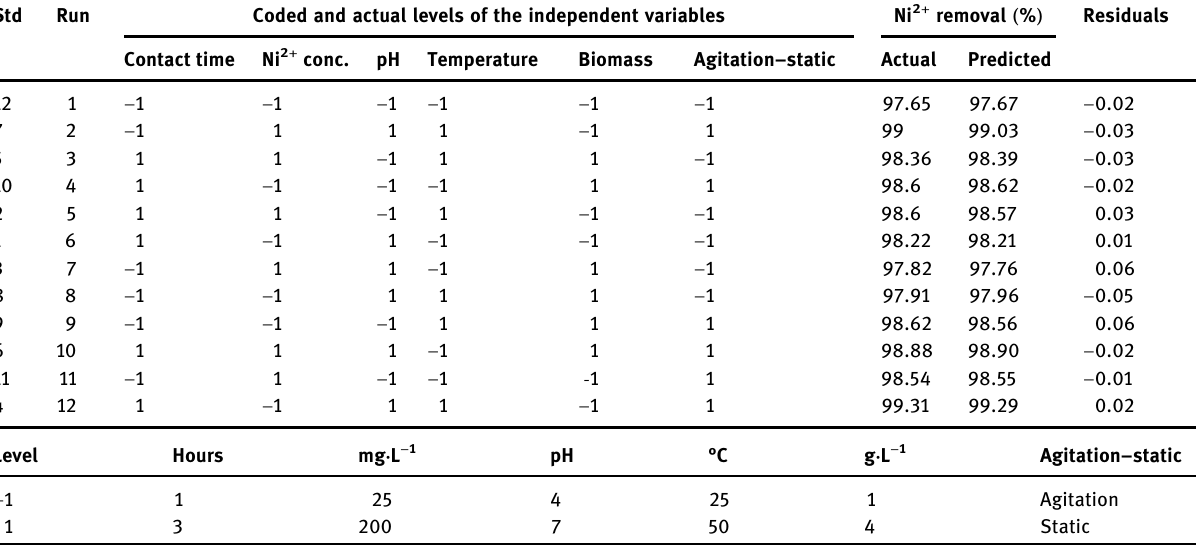
Table 1: Twelve - trial Plackett – Burman experimental design for evaluation of independent variables with coded and actual levels along with the observed and predicted values of Ni 2 + biosorption by Gelidium amansii biomass Std